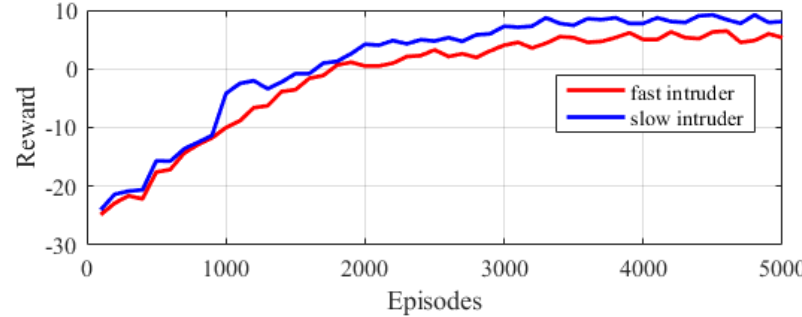
Figure 7. Average episode rewards for three USVs and one